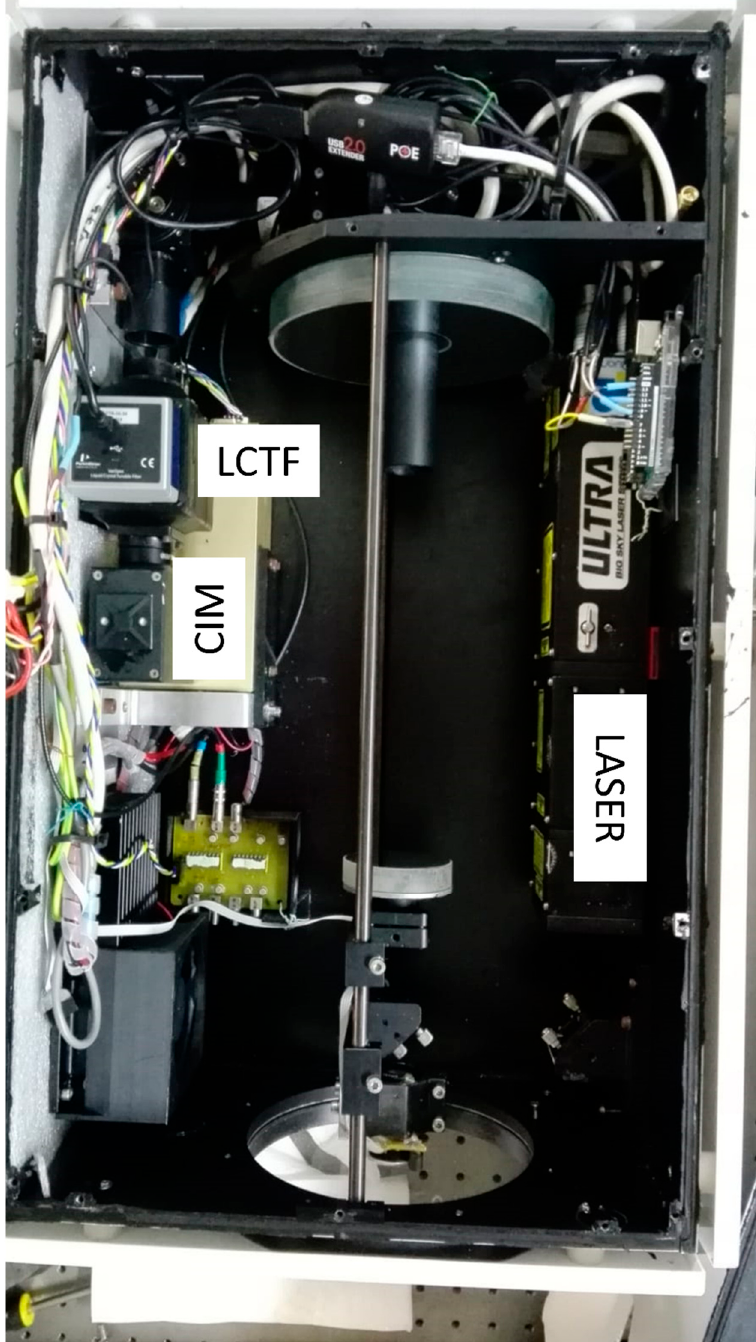
Figure A1. Photo of the LIDAR instrument main box: details of the laser, optics and detector.